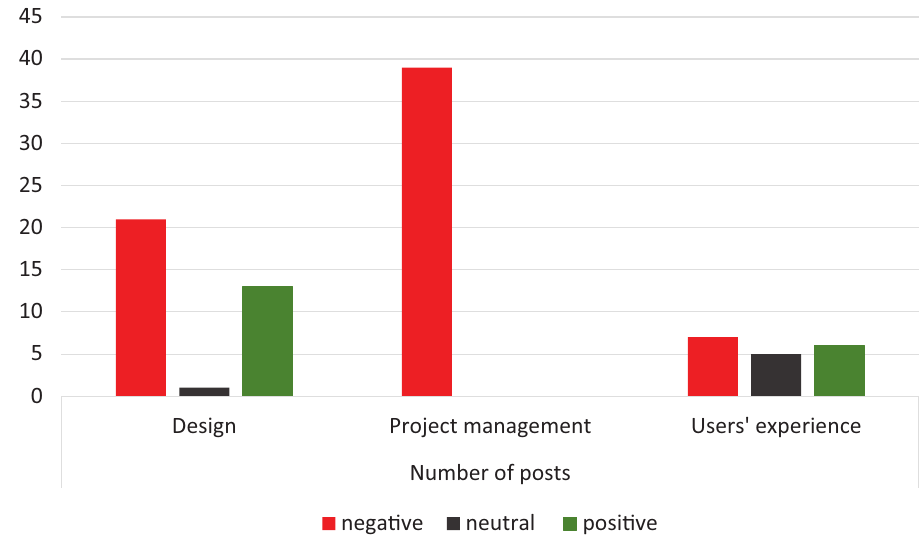
Figure 8. Negative, neutral, and positive posts, from January 2020 to January